Question: Looking at the figure, what chart type is it?
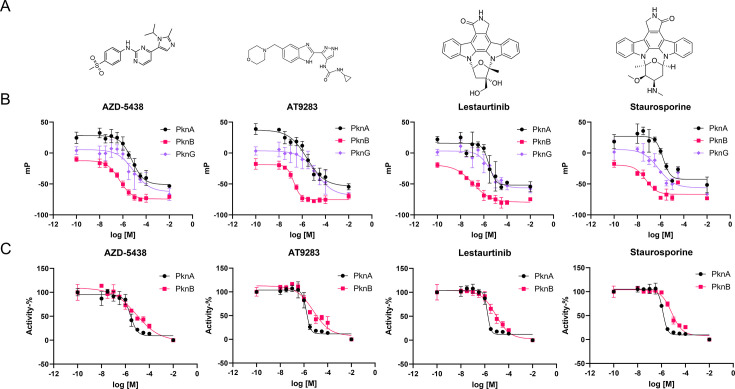
Answer: bar